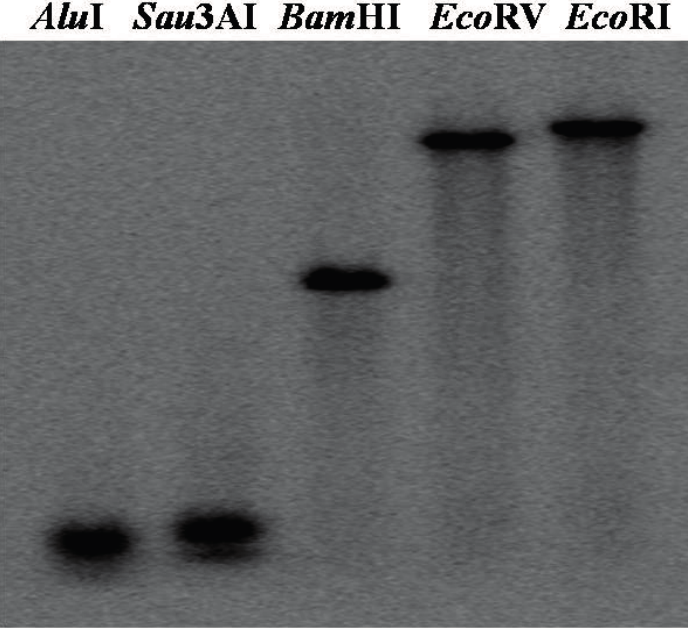
Figure 2. Southern blotting analysis of W36 . Wheat genomic DNA (20 μ g) from seedlings of wheat was digested by AluI (lane 1), Sau3AI (lane 2), BamHI (lane 3), EcoRV (lane 4), and EcoRI (lane 5) respectively, separated on a 0.8% agarose gel, and hybridized under high-stringency